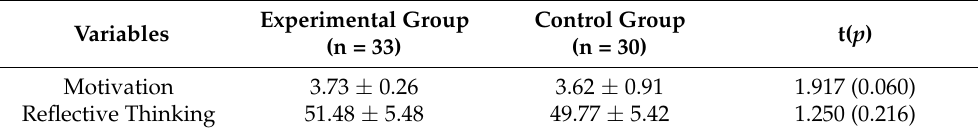
Table 3. Pretest differences between the experimental and control groups.